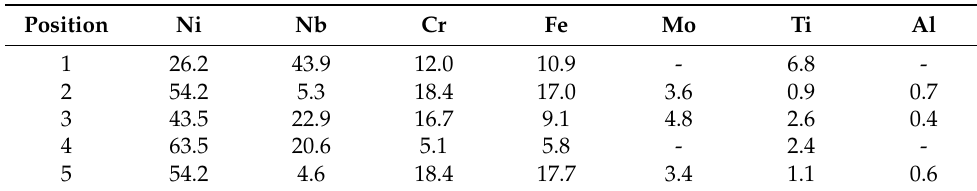
Table 2. EDS results (wt.) of positions as indicated in Figure 3.